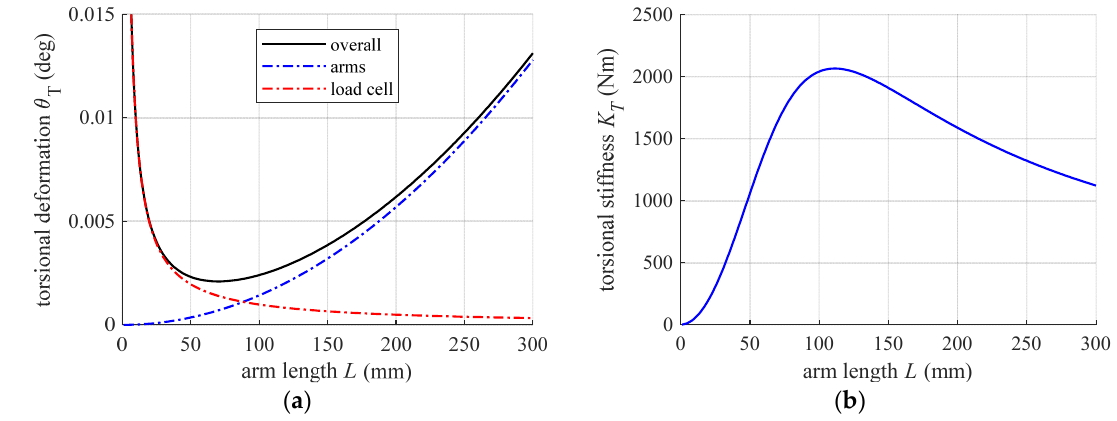
Figure 3. Changes in ( a ) torsional deformation and ( b ) stiffness by changing the length L : k LC = 0.5 × 10 6 N/m for the load cell, b L = b B = 5 mm, h L = h B = 20 mm and E L = E B = 69 GPa for the two arms.